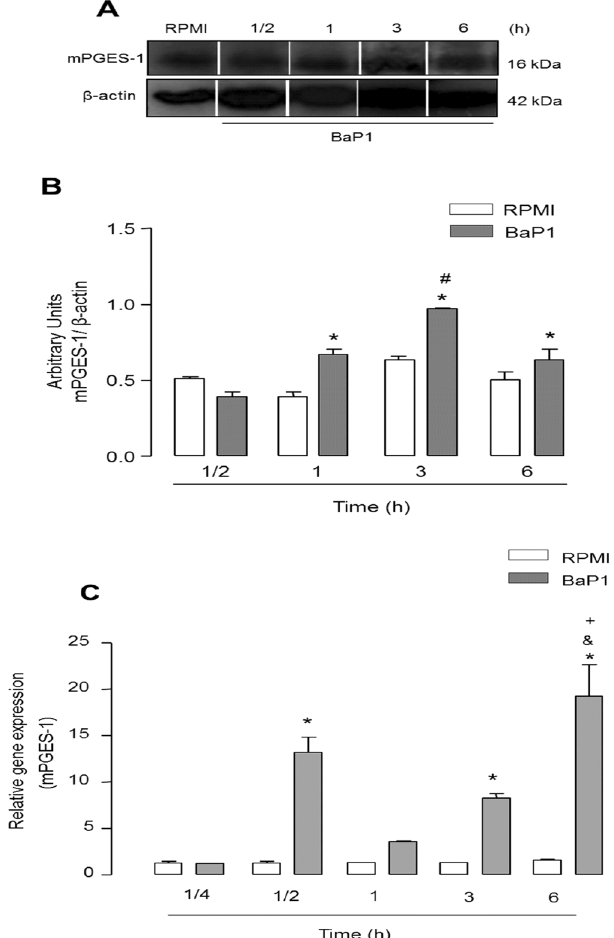
Figure 3. BaP1 up-regulates mPGES-1 protein and gene expression in FLSs. FLSs were incubated with BaP1 (12.5 µ g/mL) or RPMI (control) for 15, 30 min, 1, 3 and 6 h. ( A ) Representative Western blotting of mPGES-1 and β -actin (loading control) showing immunoreactive bands. ( B ) Densitometric analysis of immunoreactive mPGES-1 bands. ( C ) Relative gene expression in cells incubated with BaP1 and control cells determined by quantitative PCR. Densities (in arbitrary units) were normalized to β -actin densities. Results are expressed as mean ± SEM of 4–5 samples. * p < 0.05 relative to control; # p < 0.05 relative to BaP1 (1 h); & p < 0.05 relative to BaP1 (1/2 h); + p < 0.05 relative to BaP1 (3 h) (two-way ANOVA, Bonferroni post test). Blots were cropped from the full-length blots, which are demonstrated as Supplementary Figure 5(A–H) and cropped blots are indicated by